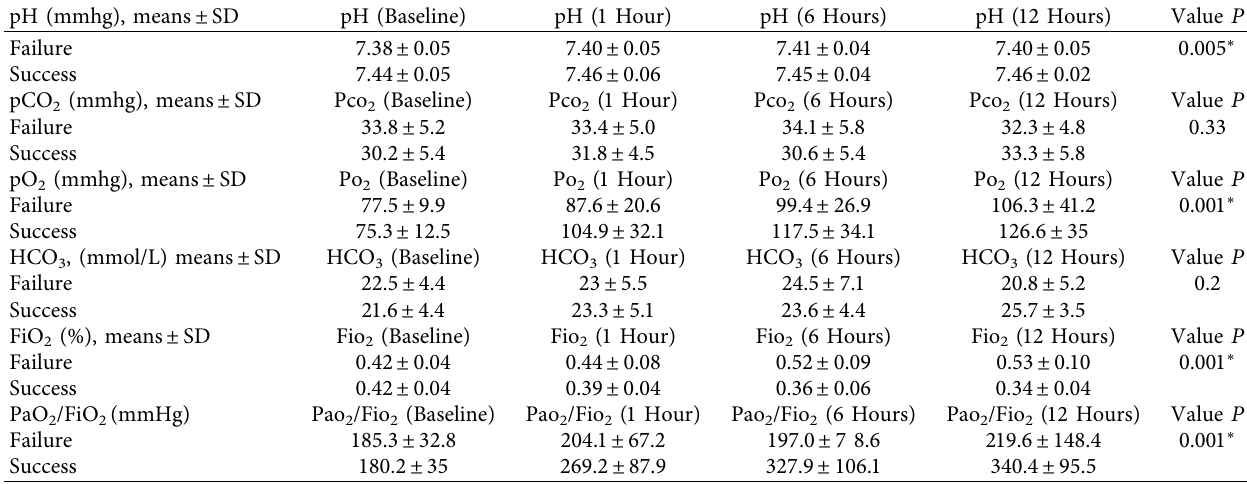
Table 4: Physiological and ventilator parameters in hypoxemic ARF from baseline to 1, 6, and 12h on BIPAP-ST-AVAPS. pH (mmhg), means ± SD